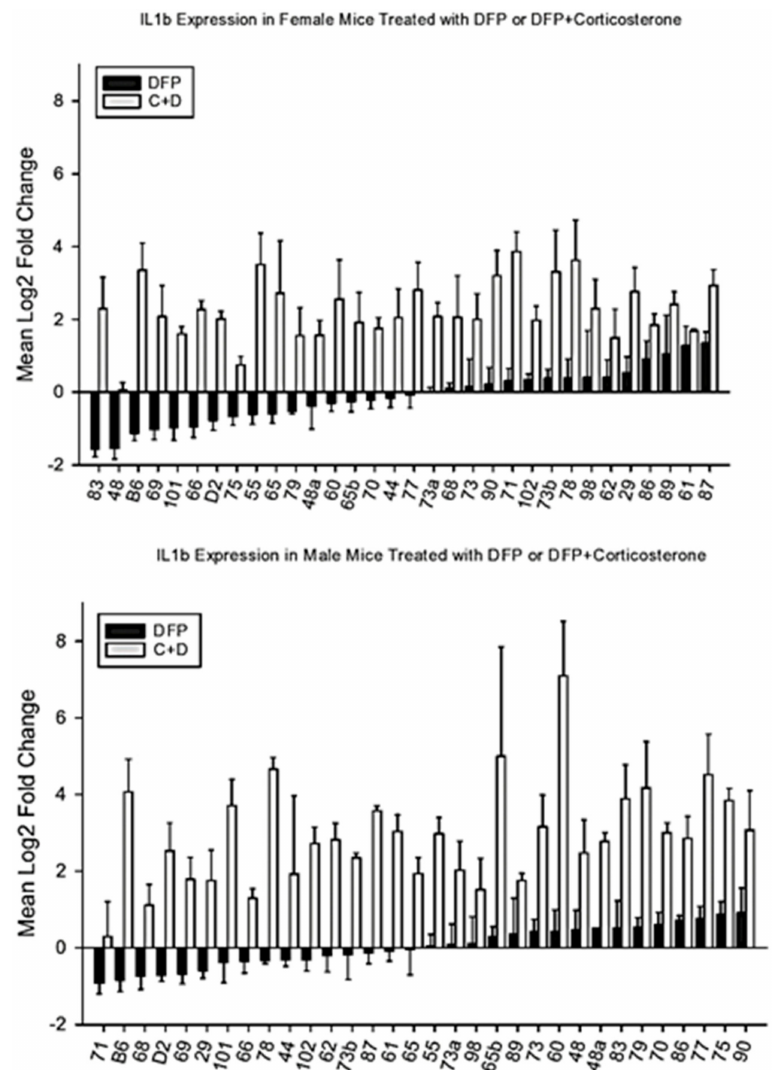
Figure 3. Mean change ( ± s.e.m) vs. control in Il1b expression in prefrontal cortex 6 h following intraperitoneal injection with diisopropylflurophosphate (DFP, 4 mg / kg—black bars) or 7 days of corticosterone in the drinking water and 6h following intraperitoneal injection with diisopropylflurophosphate (C + D, gray